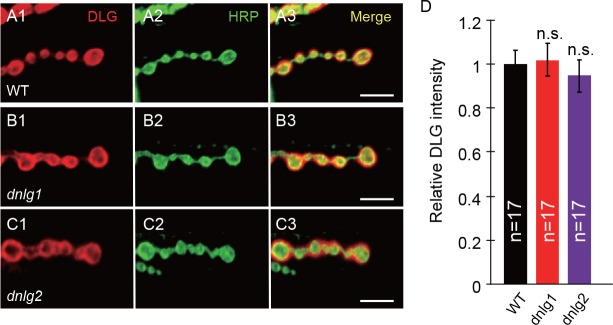
The distribution and localization of DLG are normal in neuroligin mutants.(A–C) Confocal images of (A) WT, (B) dnlg1 mutant (dnlg1ex1.9/ex2.3), and (C) dnlg2 mutant (dnlg2KO17/KO70) third instar larvae NMJ type Ib boutons labeled with anti-DLG (red) and anti-HRP (green). The distribution and protein level of DLG are normal in the dnlg1 and dnlg2 mutants compared with those in the WT control. (D) Statistical analysis of the relative DLG fluorescent intensity in the three tested lines. The data in (D) are shown as mean ± SEM; n represents the number of NMJ samples analyzed; n.s., not significant. Scale bars: (A–C) 10 μm.10.7554/eLife.30457.005Figure 1—figure supplement 1—source data 1.Sample size (n), mean, SEM, and Mann–Whitney test in Figure 1—figure supplement 1D.